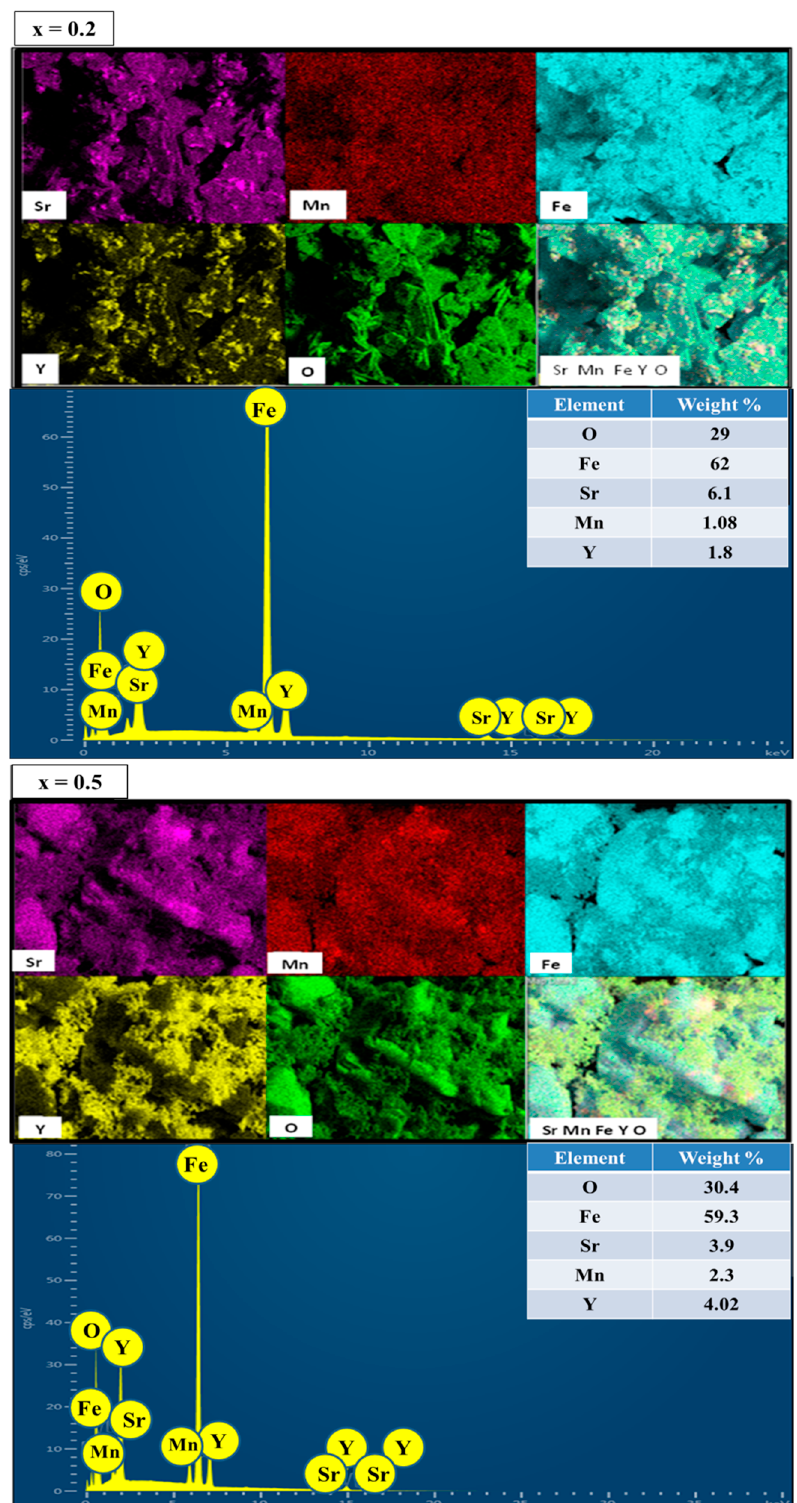
Figure 4. Elemental mapping and energy-dispersive X-ray diffraction spectroscopy (EDX) spectra of Sr 1-x Mn x Fe 12-x Y x O 19 (x = 0.2 and 0.5) nanohexaferrites.